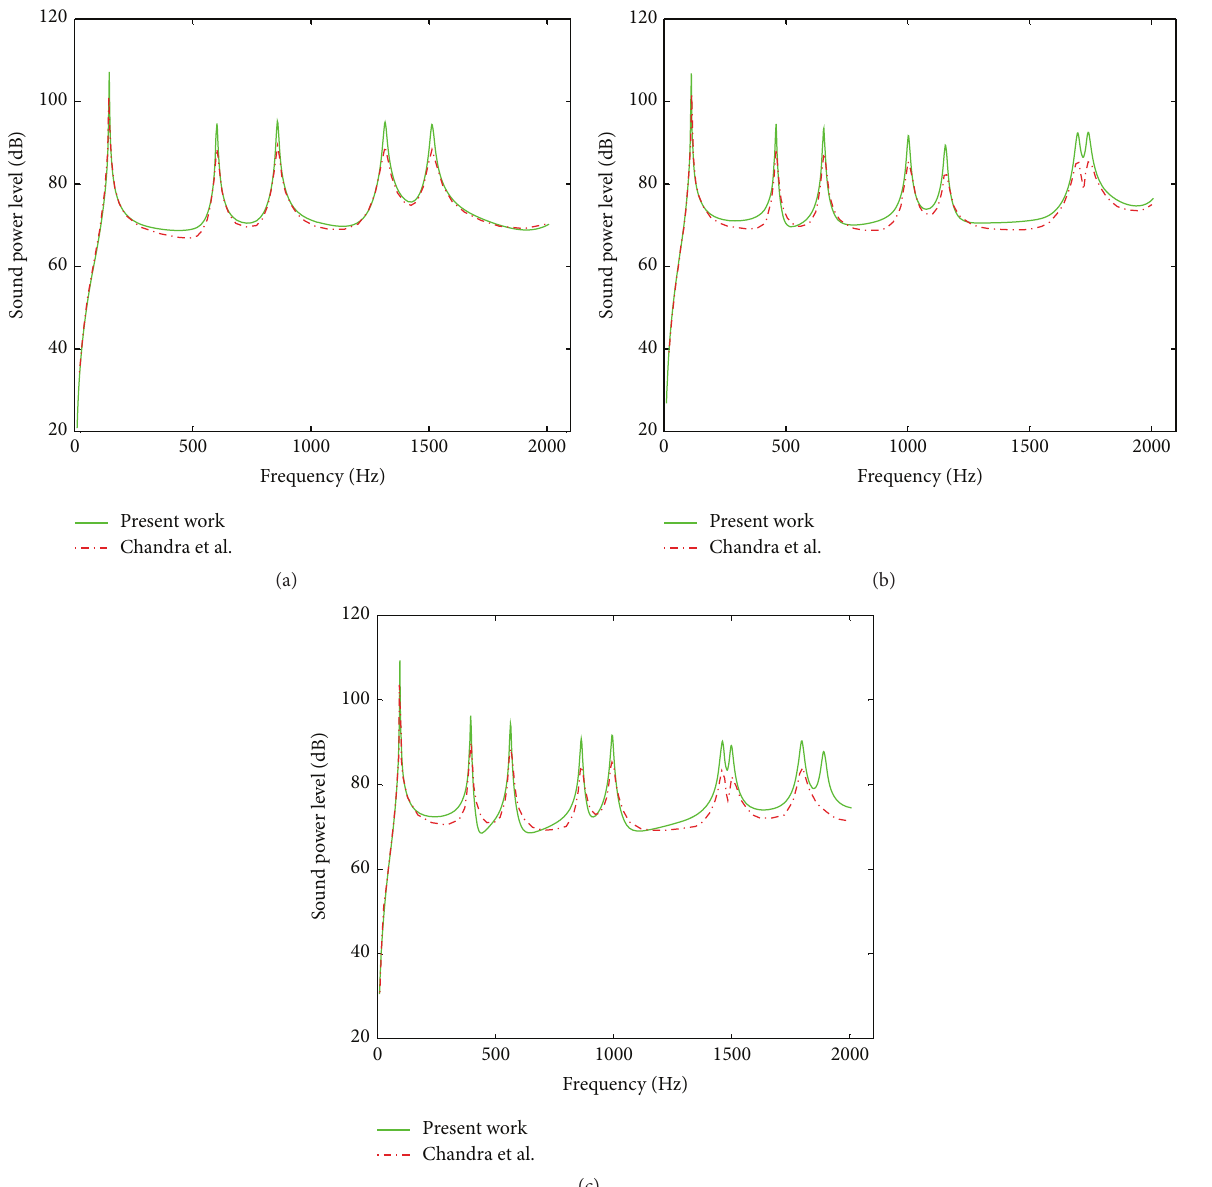
Figure 6: Comparisons of sound power level of FGM plate with Chandra et al. [22]: (a) power-law index 𝑁 = 0 , (b) power-law index 𝑁 = 1 , and (c) power-law index 𝑁 = 5